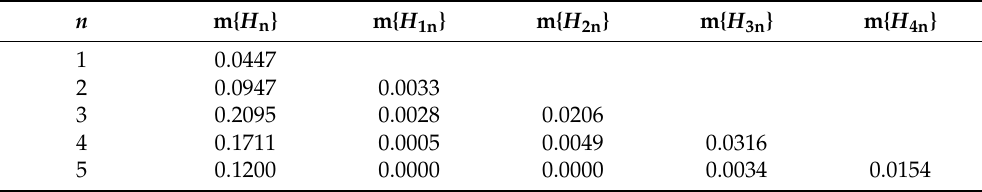
Table 12. Portfolio probability distribution function for technical risk